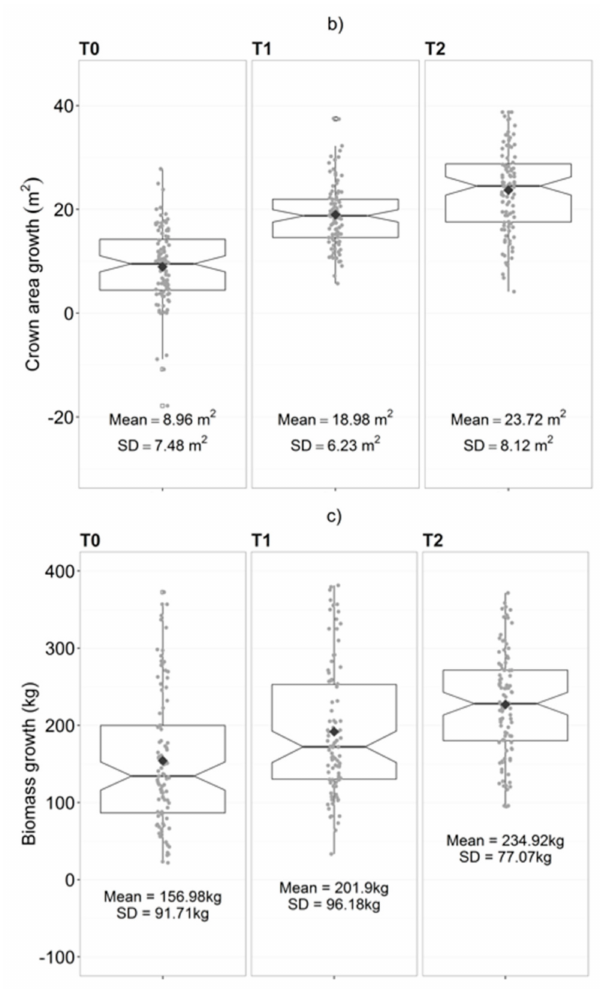
Figure 6. Average growth in height ( ∆ h SfM , a ), crown area ( ∆ ca SfM , b ) and biomass ( ∆ wa SfM , c ) in the experimental P. pinea plantations treated with three different levels of fertigation (T0, control, and T1, single fertirrigation, and T2, double fertirrigation) for the period 2015–2017, and analysis of the entire population in the study area (290 trees). The lower and upper areas of the boxes represent the respective 5th and 75th percentiles, and the horizontal band represents the median. The upper and lower whiskers extend from to the highest and lowest value, respectively, within 1.5 times the inter-quartile